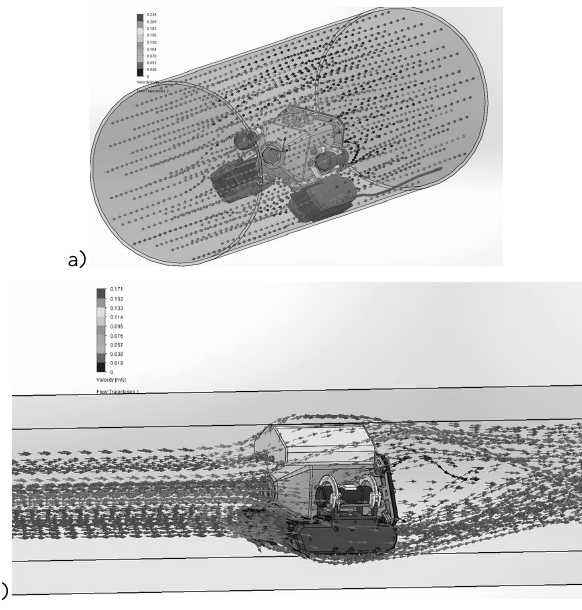
Figure 7: Distribution of liquid velocity values and trajectories of flow around the robot: a) configuration for flat surfaces (side view), b) configuration for 200 mm diameter pipes.